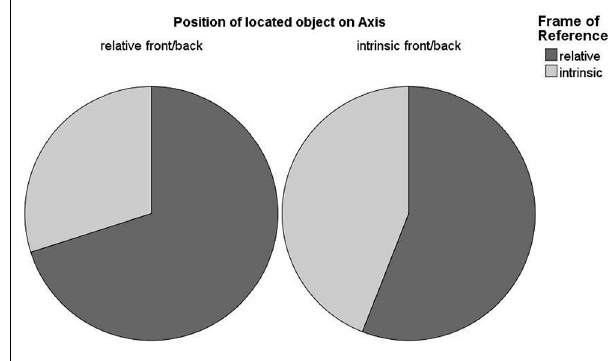
FIGURE 5 | Effect of the axis position of the located object on FOR